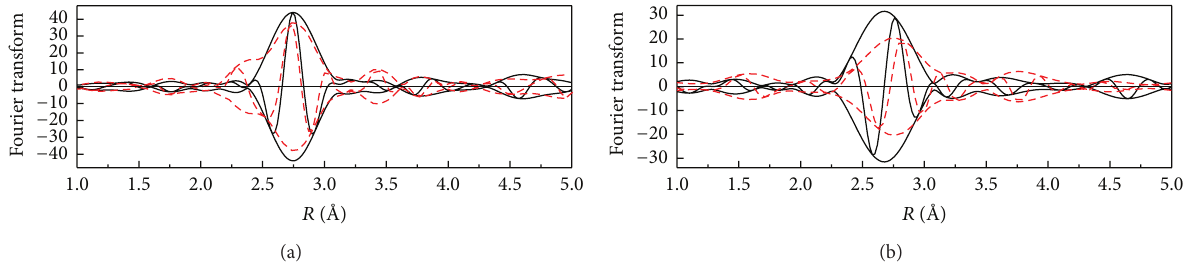
−1 Figure 10: (a) Imaginary part and magnitude of Fourier transform ( 𝑘 3 -weighted, 4.0 < 𝑘 < 15 ˚A , Pt-Pt phase and amplitude corrected) of experimental EXAFS data at Pt edge for Pt/ 𝛾 -Al 2 O 3 (black line) and Pt-Pd/ 𝛾 -Al 2 O 3 (red line). (b) Imaginary part and magnitude of Fourier −1 transform ( 𝑘 3 -weighted, 4.0 < 𝑘 < 13 ˚A , Pd-Pd phase and amplitude corrected) of experimental EXAFS data at Pd edge for Pd/ 𝛾 -Al 2 O 3 (black line) and Pt-Pd/ 𝛾 -Al 2 O 3 (red